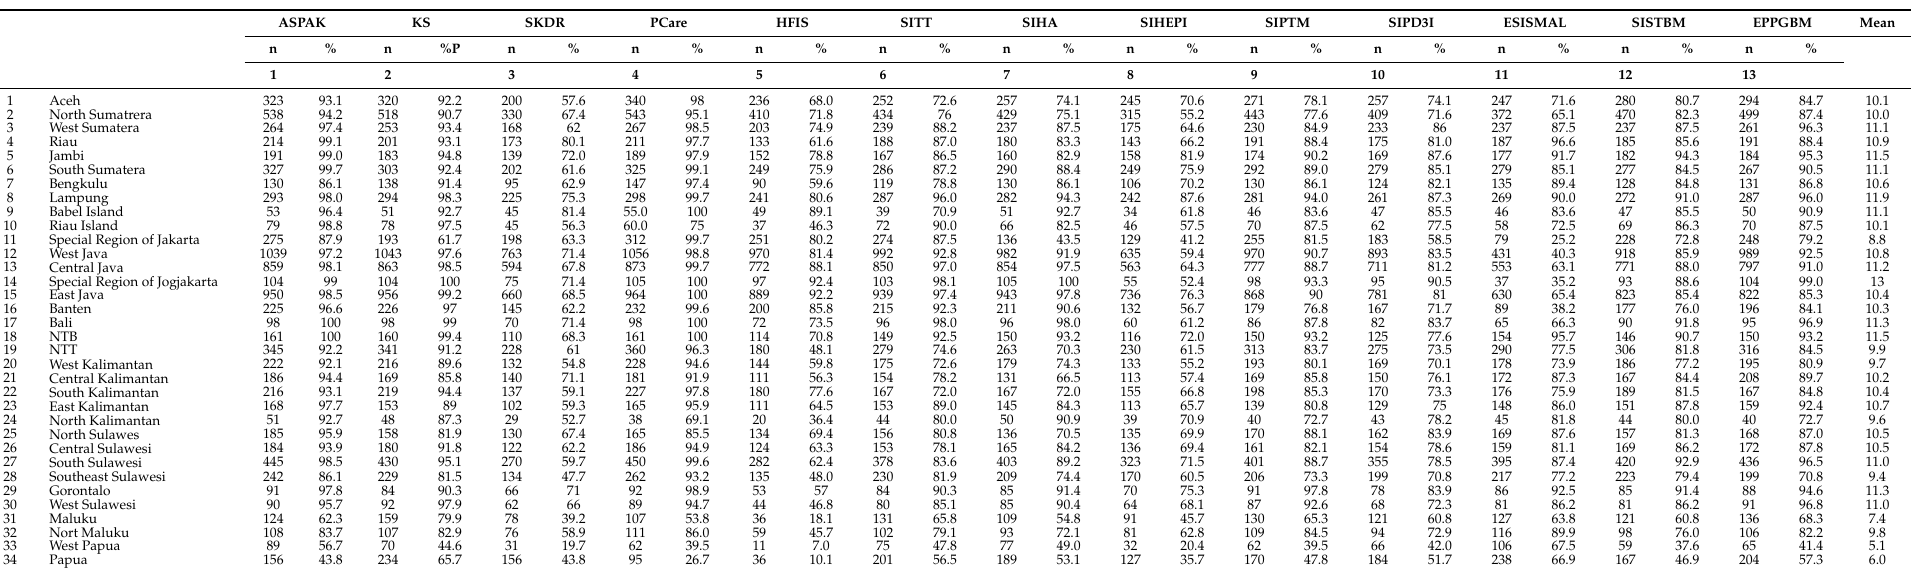
Table 4. Proportion of CHCs with Information Application or Program by